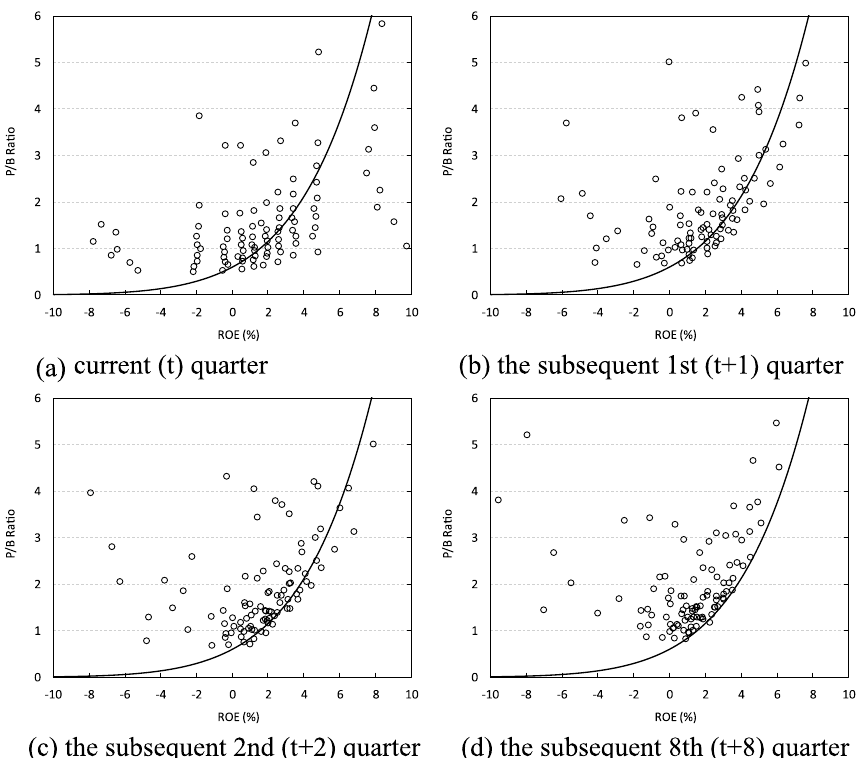
Fig. 20 ROE (X axis) and P/B (Y axis) in the current quarter and the subsequent 1st, 2nd, and 8th quarter after the portfolios are formed: Large momentum stocks